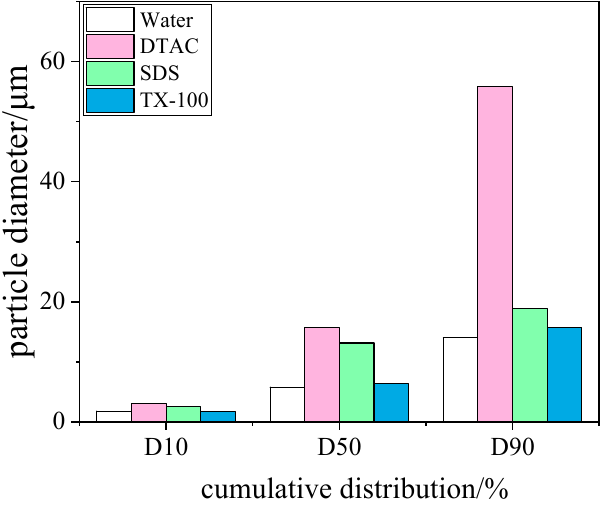
Figure 9. Histogram of particle size cumulative distribution of surfactant types.